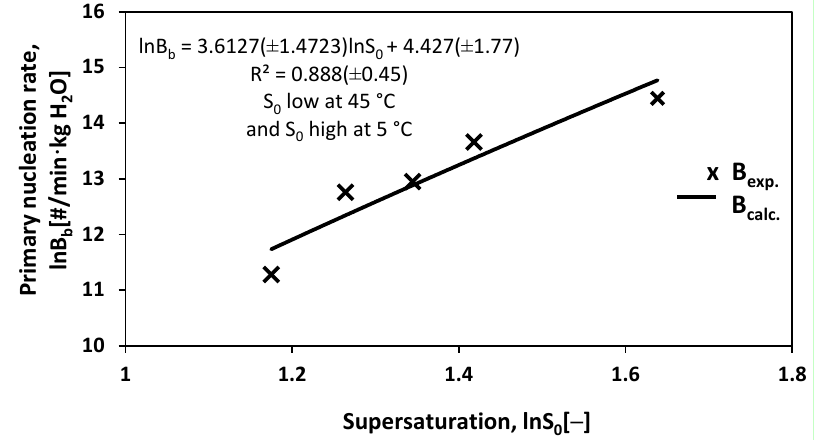
Figure 5. Correlation of the primary nucleation rate with S o for reactive crystallization of K 2 SO 4 .